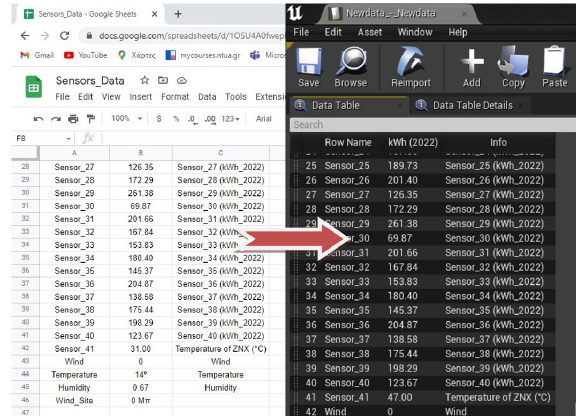
Figure 7. An example of the .csv data and the ‘twin’ table created in Unreal Engine environment